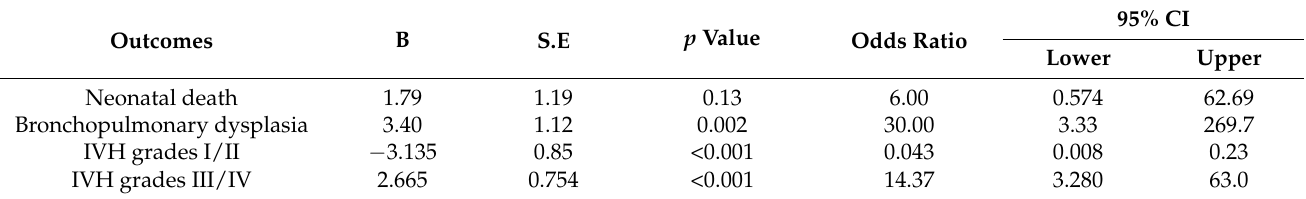
Table 5. The likelihood of early onset FGR infants, under 30 WG, included in the control group to develop adverse